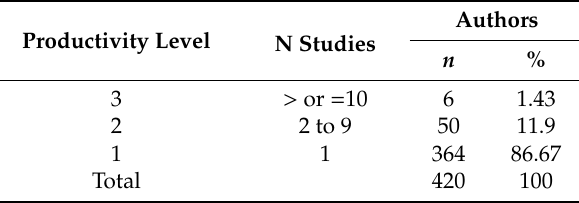
Table 3. Distribution of authors by productivity level.